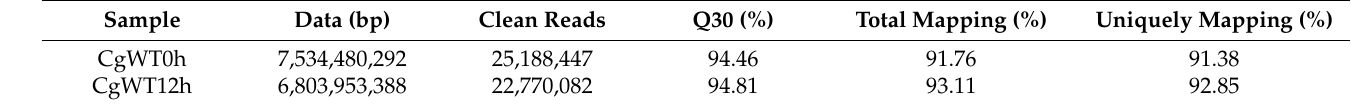
Table 1. Quality of the sequencing data for the CgWT0h and CgWT12h samples. Note: CgWT0h, C. gloeosporioides wild-type conidia; CgWT12h, C. gloeosporioides wild-type mature